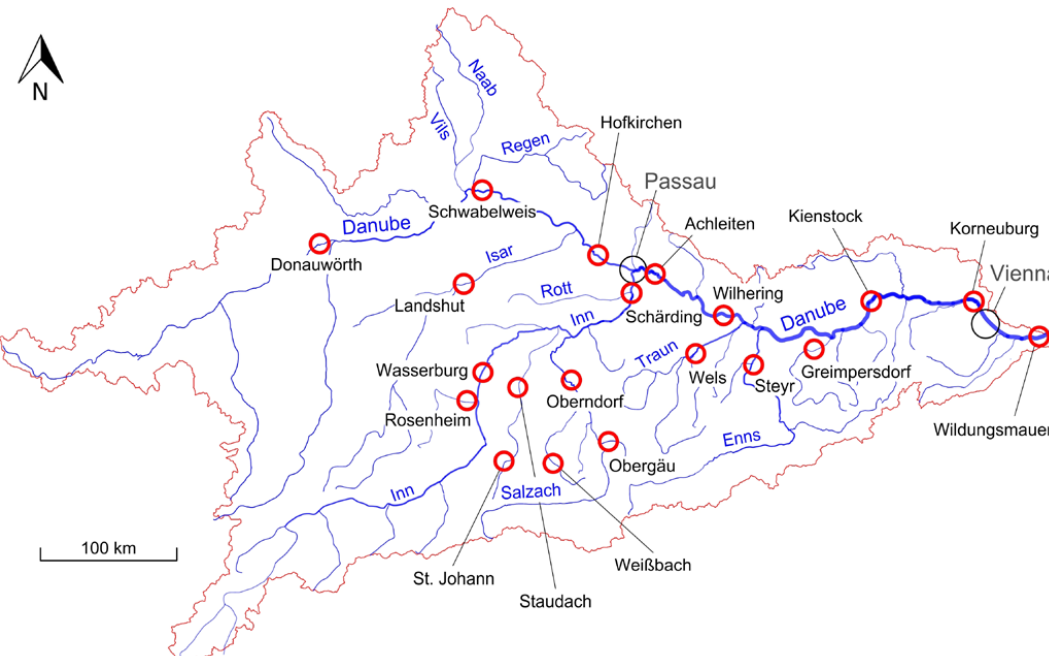
Fig. 1. The Upper Danube Basin upstream of Wildungsmauer. Red circles indicate stream gauges used in this paper. Black circles indicate the cities of Vienna and Passau. For catchment areas and mean elevations of the catchments see Appendix